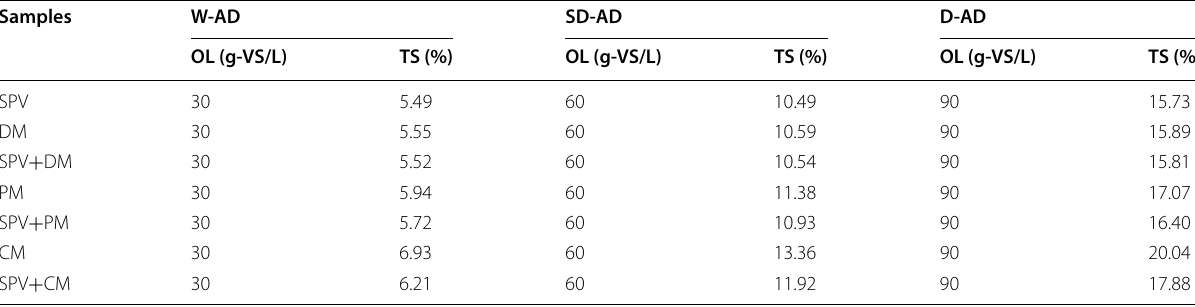
Table 2 The initial operating parameters of the anaerobic reactors